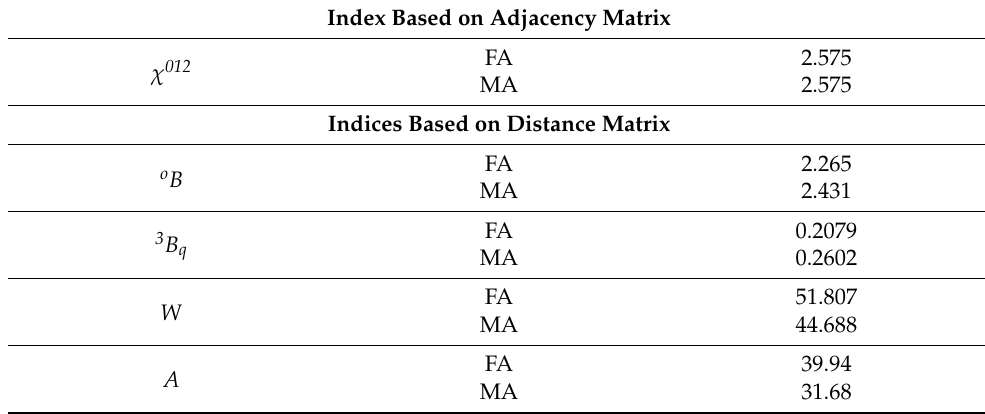
Table 5. Selected topological indices for fumaric acid (FA) and maleic acid